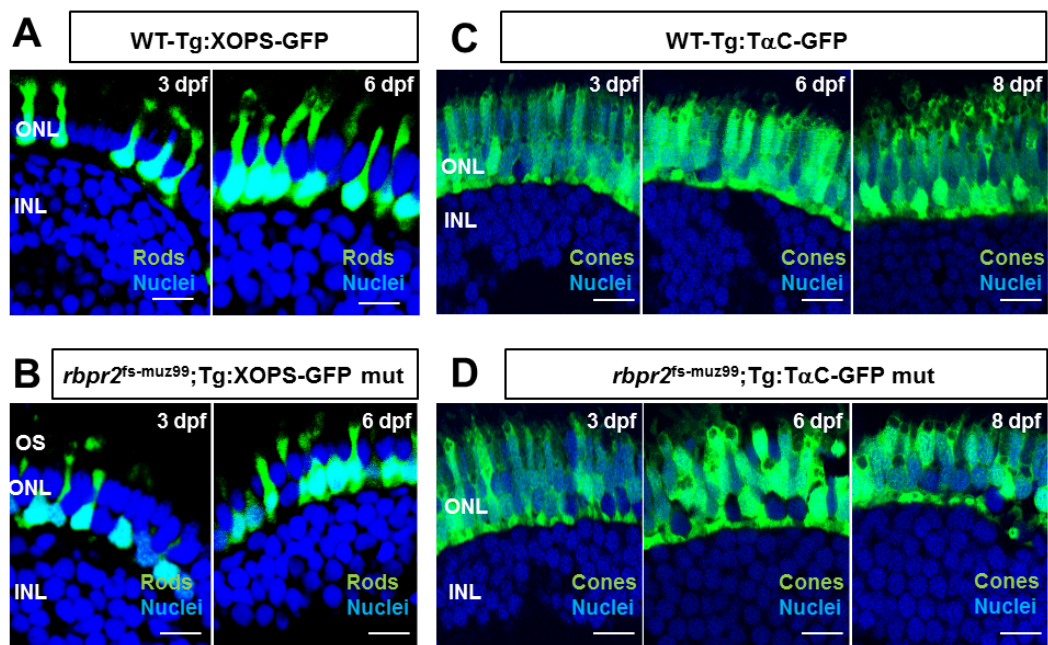
Figure 6. Rbpr2 fs-muz99 mutants affecting the RBP4 binding domain show shorter photoreceptors and progressive degeneration. ( A – D ) Compared to WT-Tg:T α C-GFP zebrafish, rbpr2 mutants showed shorter rod photoreceptors as early as 3 dpf and loss of cones by 5.5 dpf, evident by decreased soluble GFP expression in both rods and cones of mutants. INL, inner nuclear layer; dpf, days post fertilization. Scale bar = 75 µM. dpf, days post fertilization. For each genotype, approximately 25–30 zebrafish larvae retinas were imaged/analyzed.